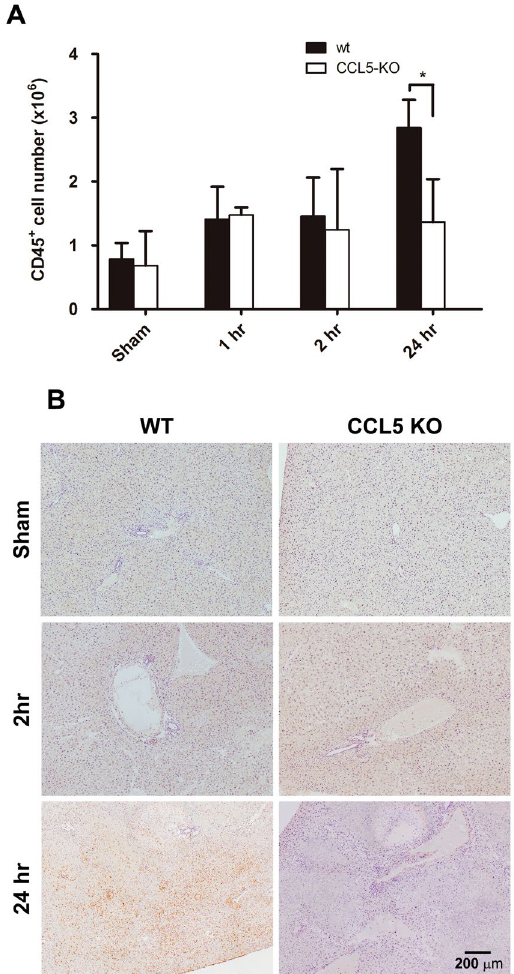
Figure 6. Assessment of intrahepatic leukocyte recruitment by flow cytometry. Intrahepatic leukocytes fractions were isolated from mice subjected to 1 hr ischemia and different reperfusion length (wt, and CCL5-KO mice), and recruiting leukocytes were analyzed by flow cytometry. ( A ) Quantity of CD45 + cells as a function of reperfusion time. Population percentages of CD45 + cells from the results of flow cytometric analysis were plotted against respective lengths of reperfusion. Mean ± SD, n = 4–7. * p < 0.05. ( B ) Immunohistochemistry of CD45 + cells as a function of reperfusion time. Scale bar = 200 μ